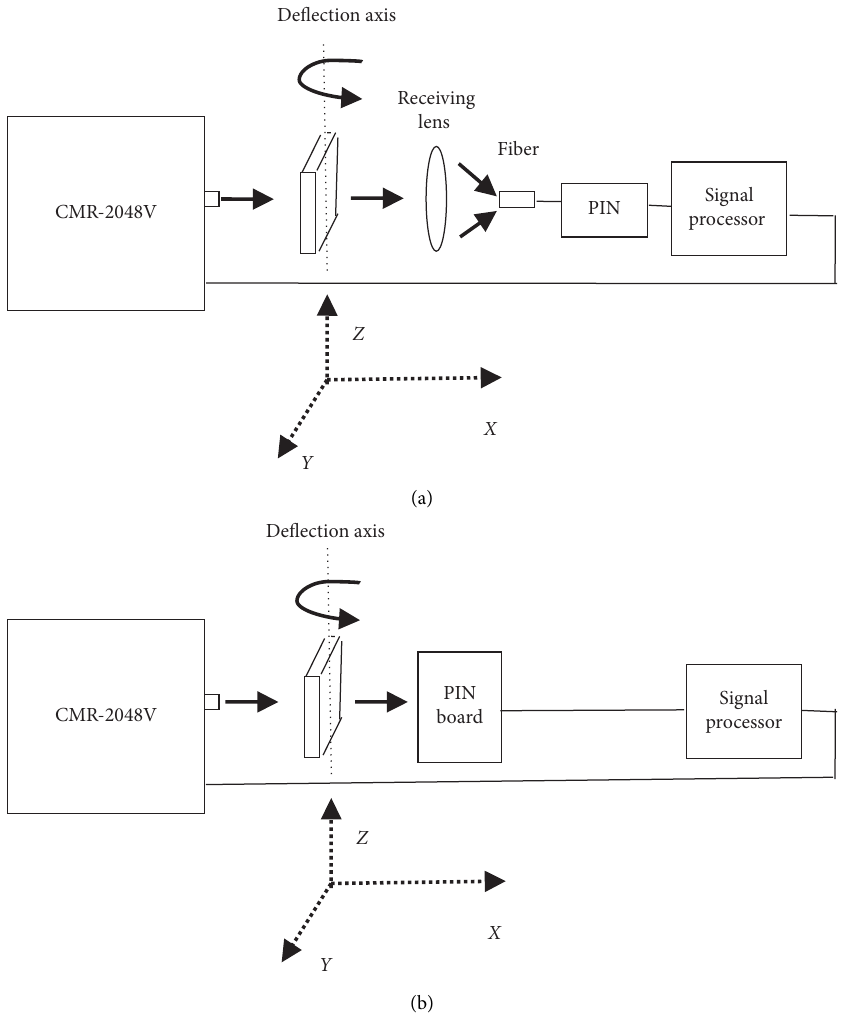
Figure 6: The experiment of bit error rate test: (a) adopting the typical receiving system; (b) adopting the new receiving system.